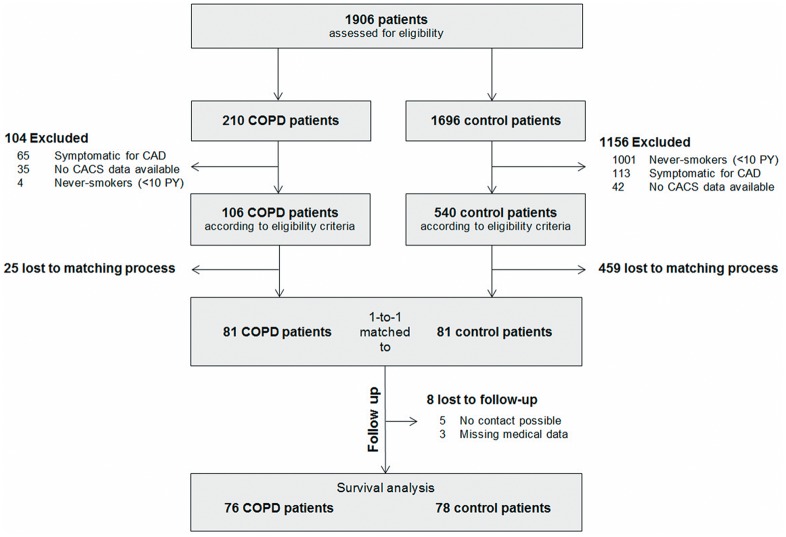
Patient flow chart.